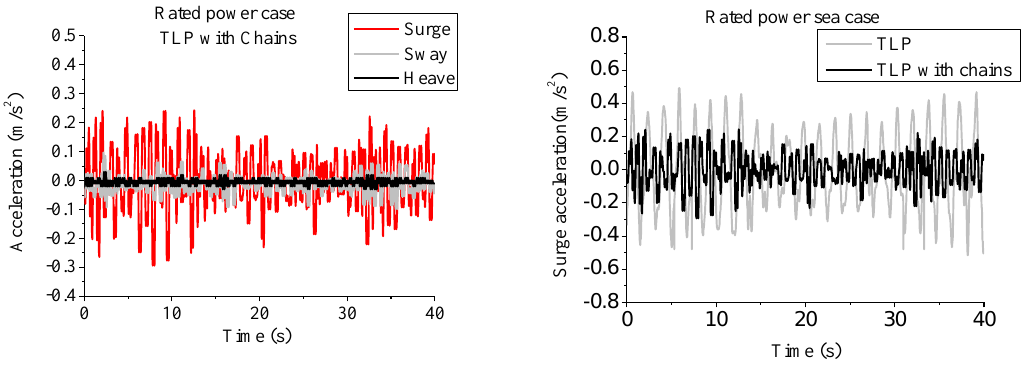
Figure 6. The comparison of the two FOWT’s acceleration responses under rated power case. ( a ) Acceleration responses ( left ); (b ) Surge acceleration comparison ( right ).